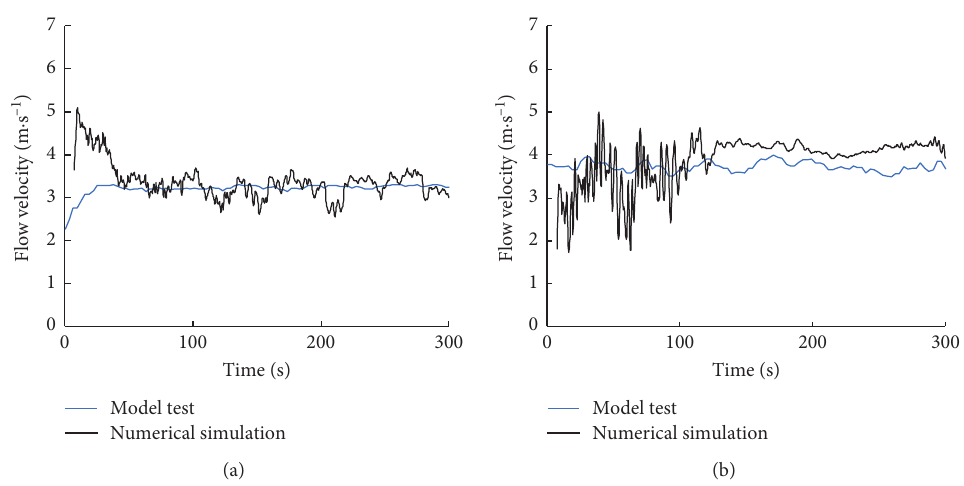
Figure 11: (a)Flow velocity at Point 2 of Scheme 3. (b)Flow velocity at Point 2 of Scheme